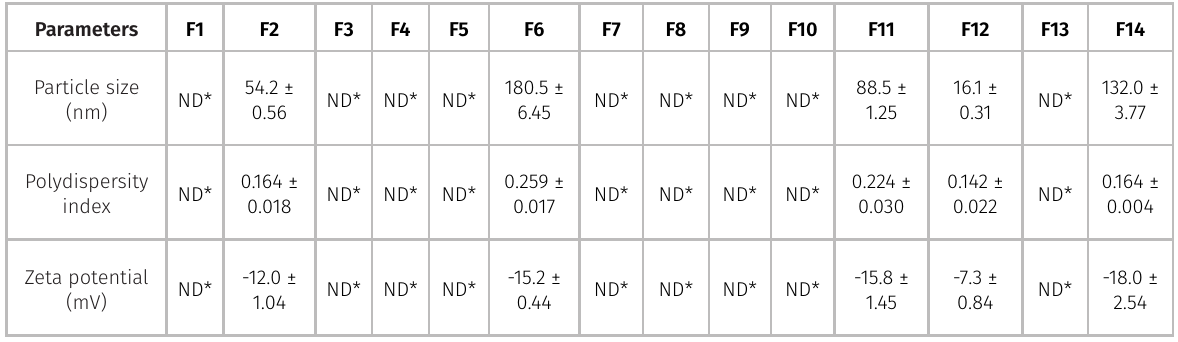
Table II. Mean particle size, polydispersity index and zeta potential of the BC nanoparticles developed by spontaneous emulsification